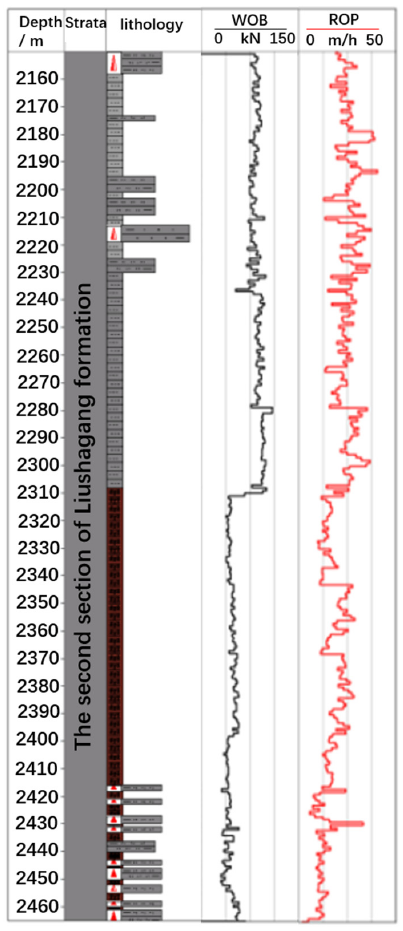
Figure 21. Lithology–WOB–ROP profile of Well X-2.